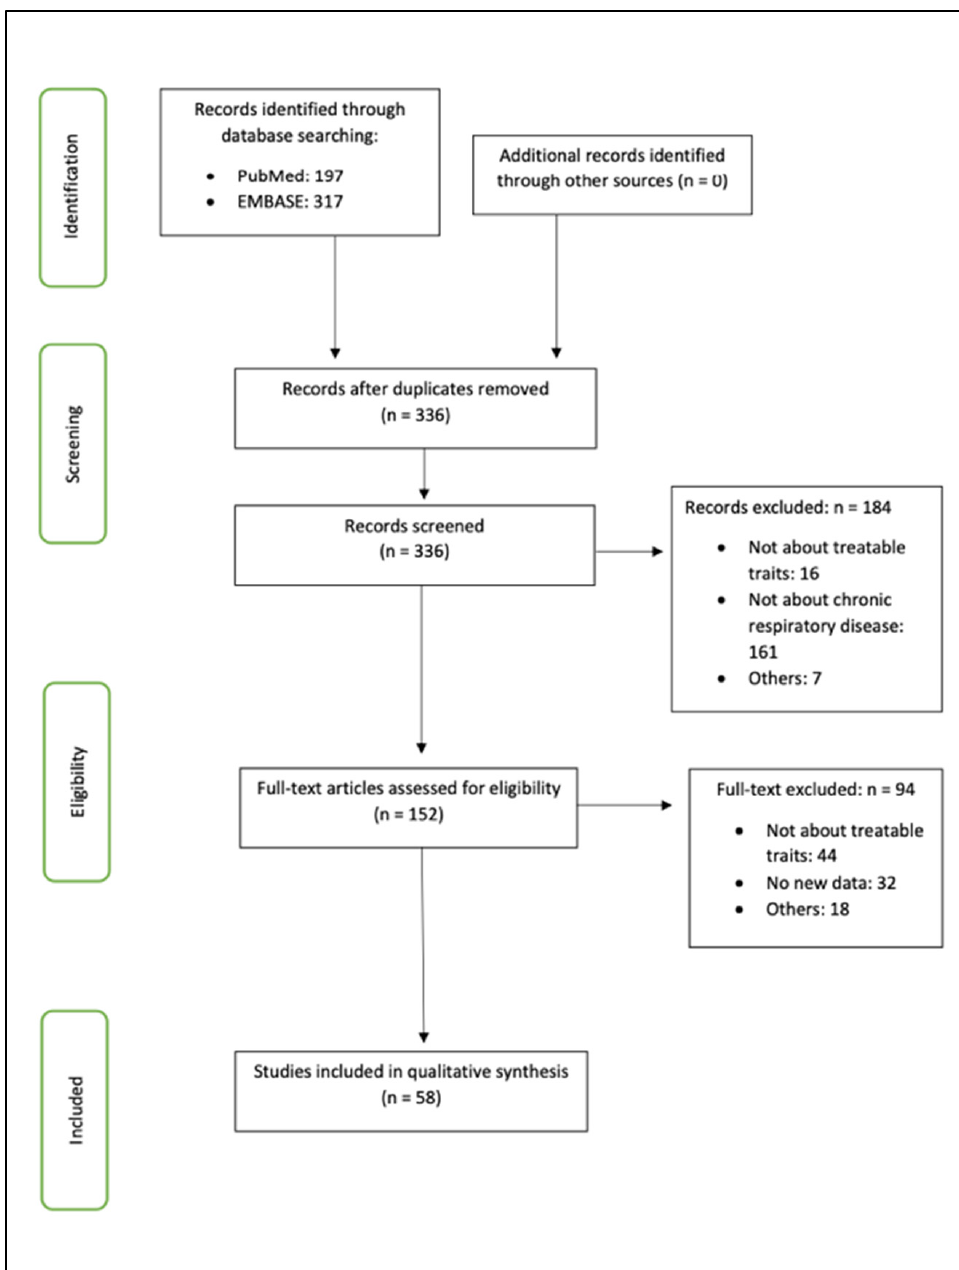
Figure 1. PRISMA flow diagram.